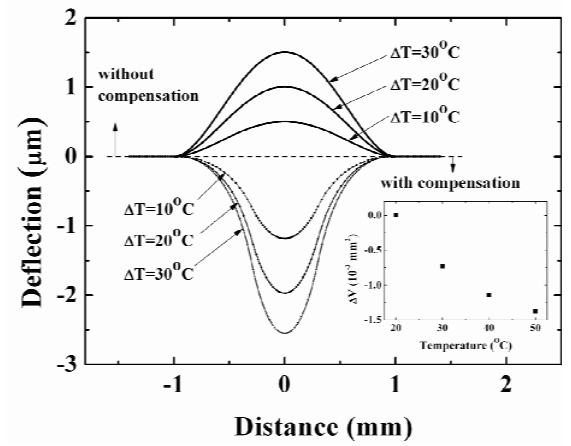
Figure 8. The deflection along diaphragm diameter without Al ring expanded by sealed gas, and the deflection with Al ring simulated with ANSYS. The below right is the volume change. The radius (R) is 1 mm, and the inner radius of compensation ring is 300 μ m. Reference temperature is 20